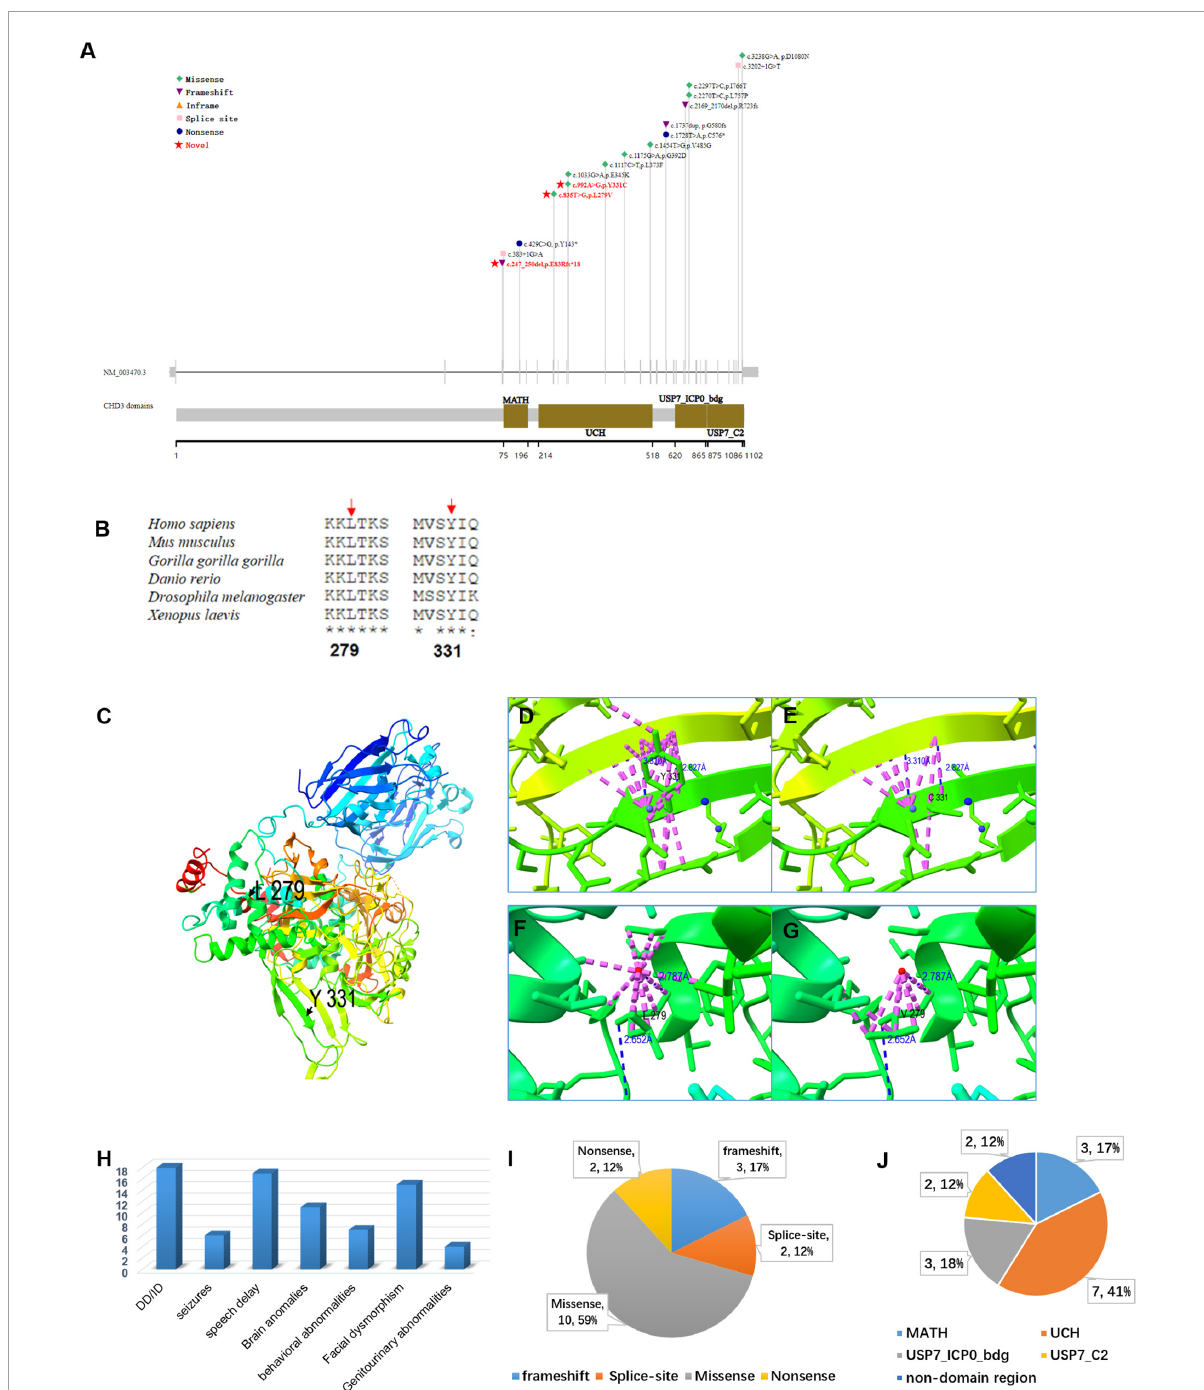
FIGURE4 (A) A report on the distribution of USP7 gene variants and protein domain pattern map in history. Variations in red font indicate loci discovered. (B) The conservation analysis of USP7 amino acid sequence in multiple species on missense variants (p.Leu279Val and p.Tyr331Cys). (C) The panoramic 3D map of wild-type USP7 protein. Although the p.Tyr331Cys (one hydrogen bond with Gly392) (D,E) and p.Leu279Val (three hydrogen bonds with Thr276, Ser282, and Phe283) (F,G) and wild-type and mutant hydrogen bonds did not change, interaction between the benzene ring of TYR331 and neighboring atoms, interaction between LEU279 and neighboring atoms, the amino acid side chain following mutation changed. Interactions between atoms within 4A are represented in dashed pink, and hydrogen bonds in blue dotted lines, the red and blue dots represent water molecules; (H) bar graph showing the distribution of the relevant clinical features among all the subjects (20) identified as having USP7 variants. The y -axis shows the number of patients. (I) A pie chart showing the percentage distribution of USP7 variants. (J) A pie chart showing the proportion of USP7 variants in the different functional